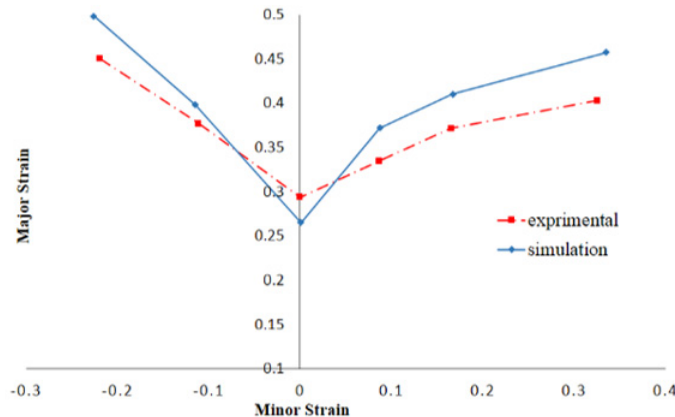
Figure 9. Comparing the experimental and simulated FLDs for a 1 mm-thick AA 6061 sheet at 200 mm/min speed.